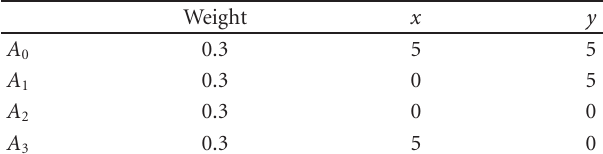
Table 1: An example of the signature A .